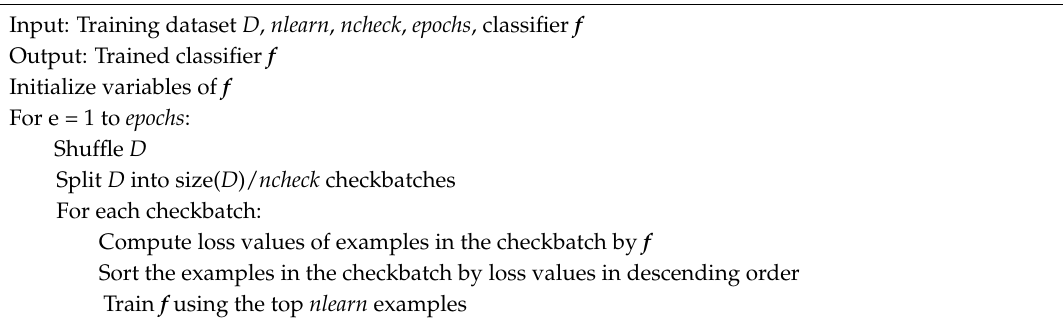
Algorithm 1: Hard example mining in